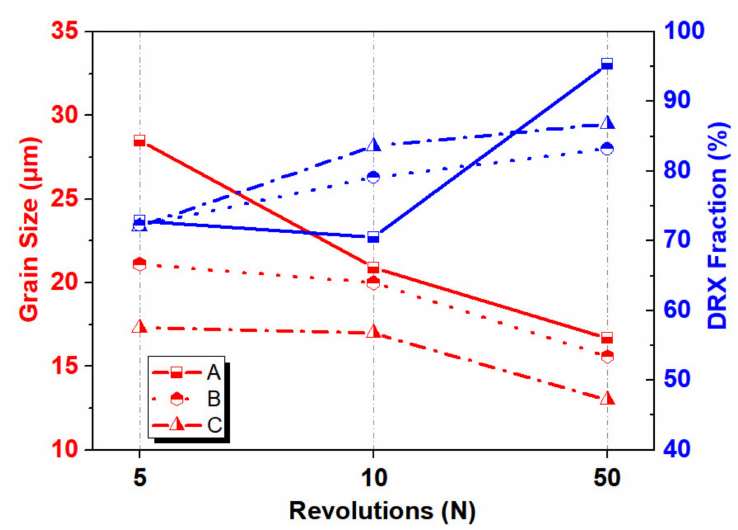
Figure 6. The comparison of average grain size and DRX fraction with di ff erent rotating revolutions and